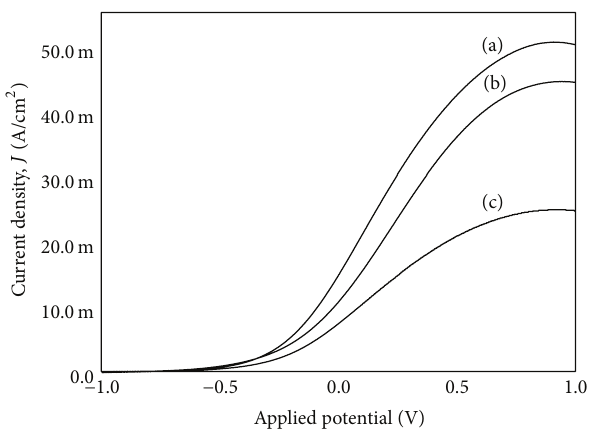
Figure 7: Current density-applied potential characteristics for (a) 1V, (b) 2 V, and (c) 3 V under visible